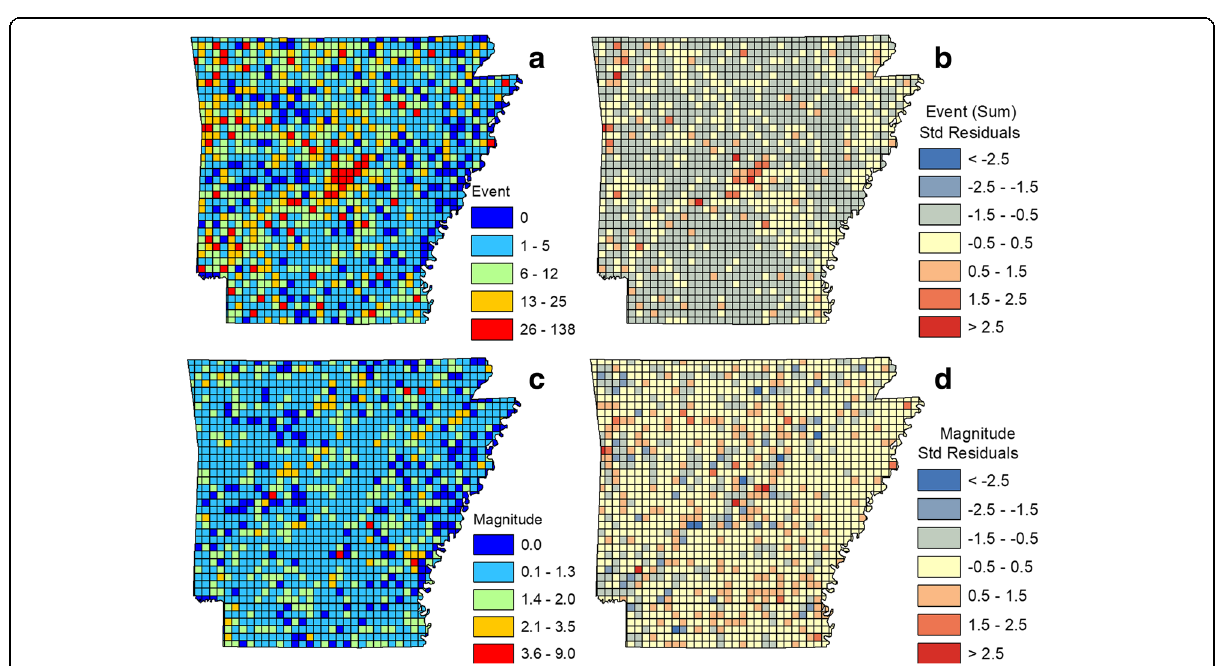
Fig. 11 Ordinary Least Squares (OLS) regression analysis for the explanatory variables influencing hail (grid cell = 10 × 10 km): a frequency b OLS are dominant within 1 standard deviation (Std) for the explanatory variable residuals c magnitude d OLS show low (< 1) standard deviation for residuals signifying robustness of model